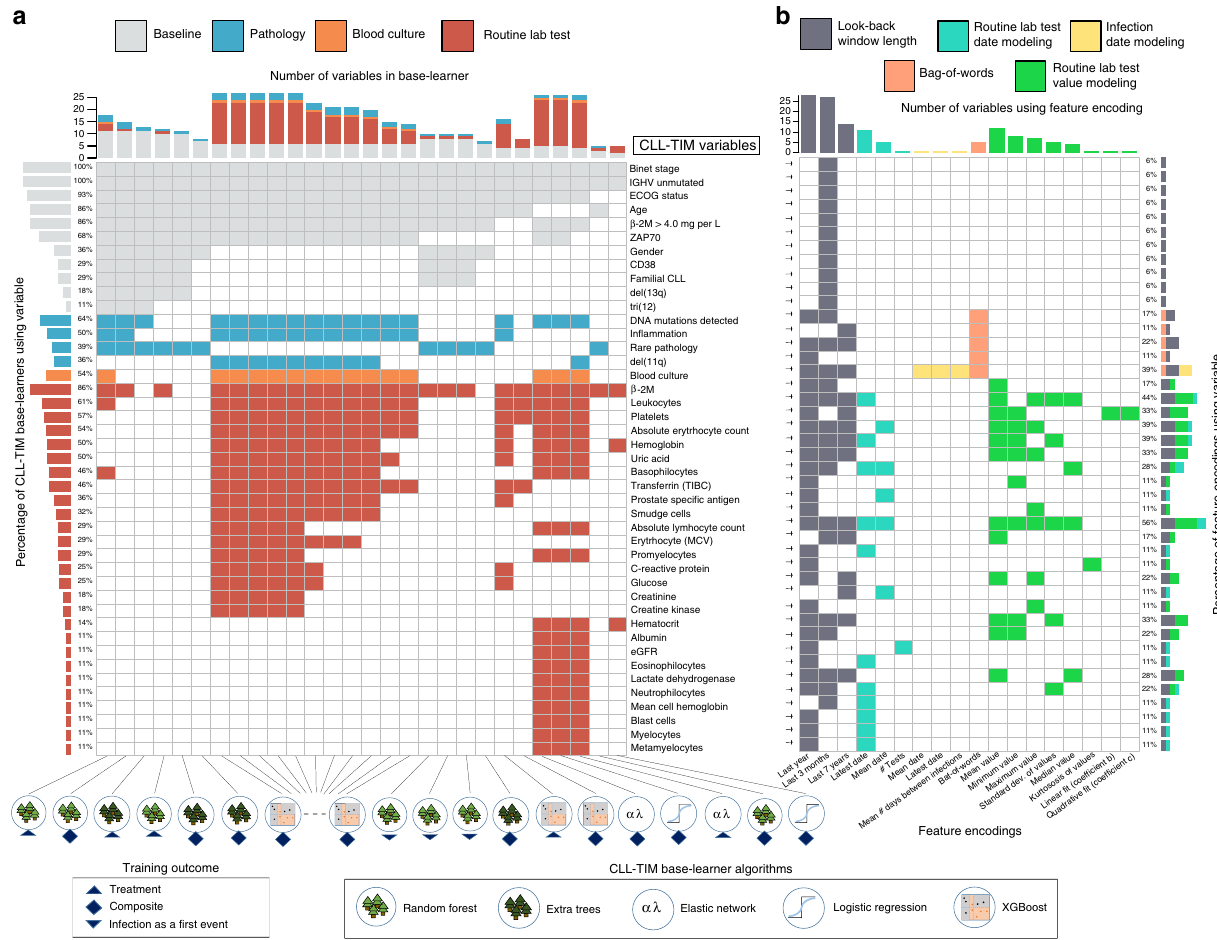
Fig. 2 CLL-TIM ensemble composition: base-learners, variables and feature encodings. CLL-TIM is composed of 28 base-learners: 20 model the composite outcome, 5 model CLL treatment outcome and 3 model infection as a fi rst event. Base-learners include 13 XGBoost, 7 Random Forests, 4 Extra Trees, 2 Elastic Network and 2 Logistic Regression models. a Distinct variables used in CLL-TIM and b features that these variables are encoded into. Each variable may have multiple feature encodings (right panel in b ) and can hence represent multiple features in the ensemble model. For instance, the variable Haemoglobin is encoded into four features; the mean, minimum and variability of the test result and the number of days since the last test. These four features were calculated on patient look-backs of 3 months, 1 year, and 7 years. In total, the feature encodings selected for 84 variables in CLL-TIM resulted in a set of 228 features (Supplementary Data 1). For visualization purposes, here we show a condensed representation with only variables that were used by at least 10% of CLL-TIM ’ s base-learners (left panel in a ). CLL-TIM models: rates of change, variability, average values and extremities in the results